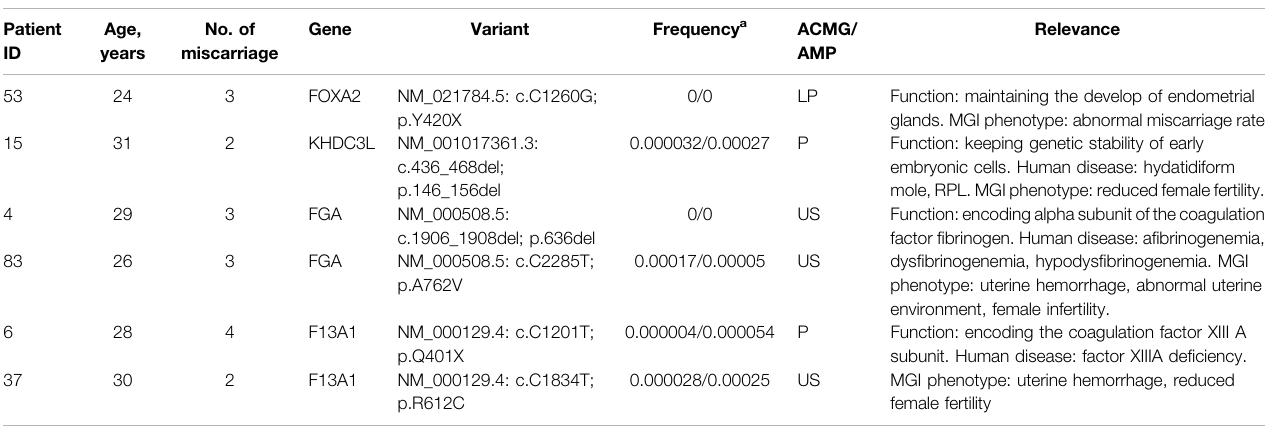
TABLE 1 | Potential causative variants in patients with recurrent pregnancy loss.